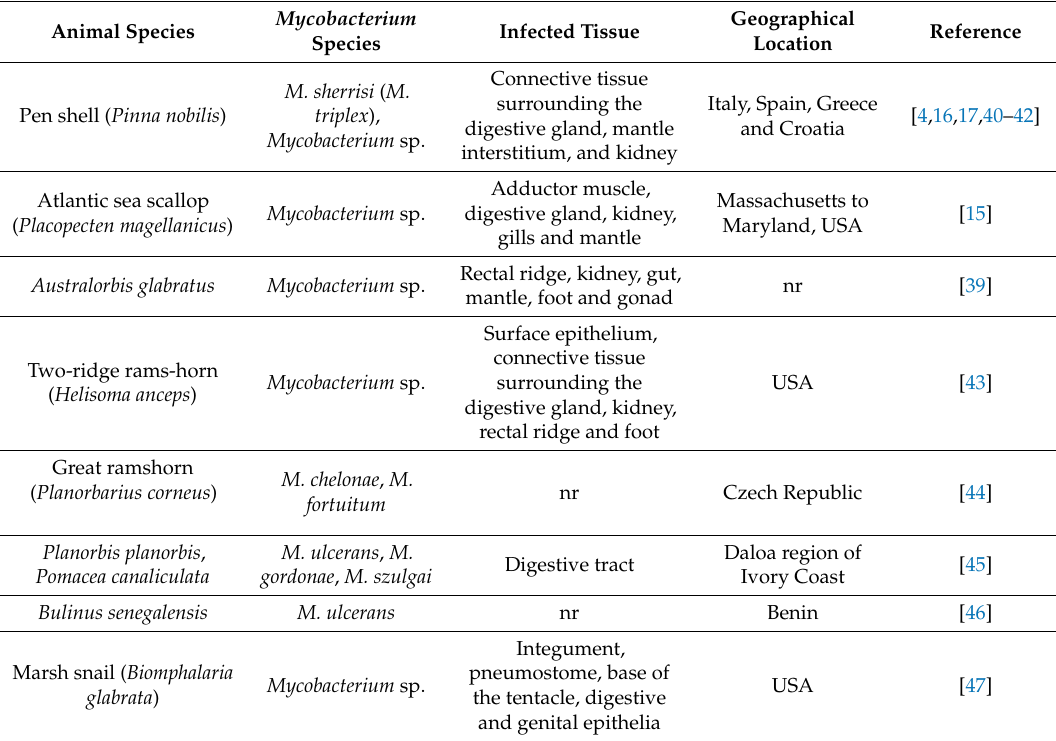
Table 1. Summary of molluscs’ mycobacterioses, including animal species, Mycobacterium species, infected tissue, geographical location, and